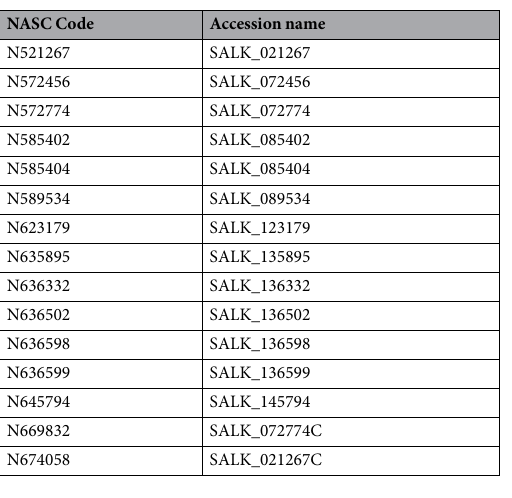
Table 1. The SALK T-DNA insertion lines for the genomic locus At4g36280 that were used in this study.